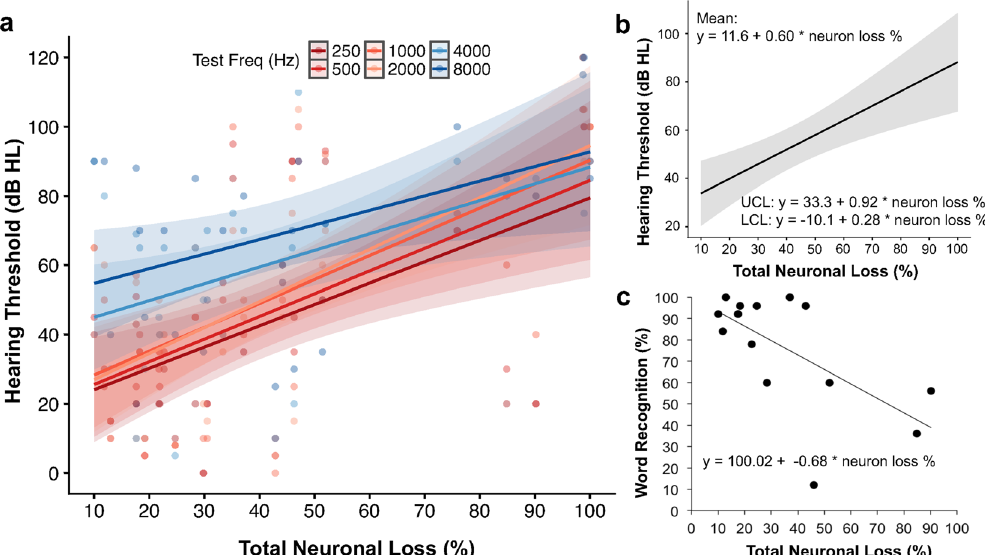
Figure 4. Primary neuronal loss correlates significantly with elevated audiometric thresholds and poor word recognition scores. Confidence intervals are represented as shaded areas around regression lines and are measures of 95% precision for predicted slopes and intercepts. ( a ) Linear mixed regression model correlating total neuronal loss (% of age-based mean) with audiometric thresholds (dB HL) within patients at each individual test frequency (n = 30 ears). Solid lines, linear regressions per audiometric test frequency (Freq); data points, individual threshold observations color-coded by audiometric test frequency. Conditional f test with Kenward-Rogers correction for degrees of freedom reveals that slopes of these lines are significantly different than zero (p < 0.001), but not significantly different from one another (p = 0.10). ( b ) Averaging across all six audiometric test frequencies yields a mean threshold increase of 6.0 dB HL per 10% total neuronal loss; shaded area, 95% confidence interval. ( c ) Total neuronal loss (% of age-based mean) correlates with poor word recognition (n = 15 ears). Mean word recognition score decreases by 6.8% per 10% total neuronal loss (r = − 0.644).